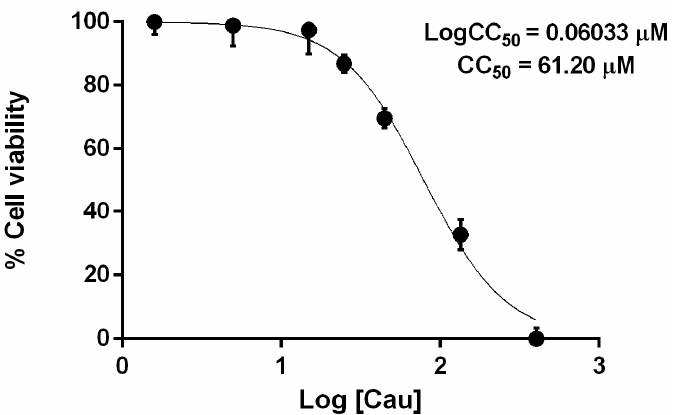
Figure 1. Effect of Cau on AGS cell viability. AGS cells were cultured with different concentrations of Cau for 24 h. Results were obtained by combining three independent experiments and represented as mean ± SD compared to control cells (100% viability).